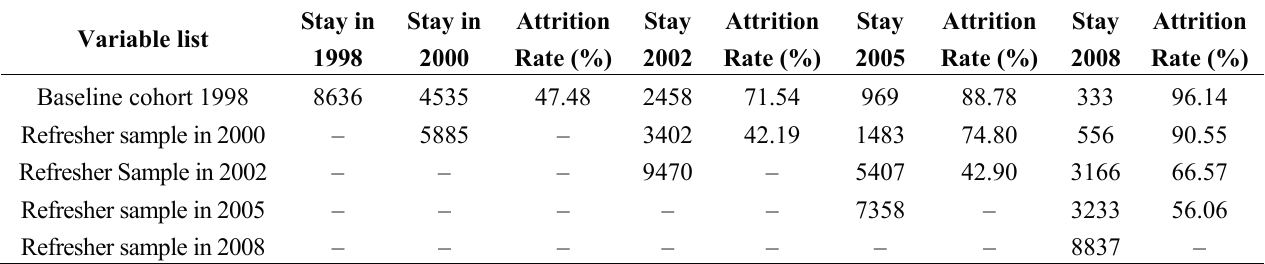
Table A1. Data structure & attrition for the Chinese elderly living in the